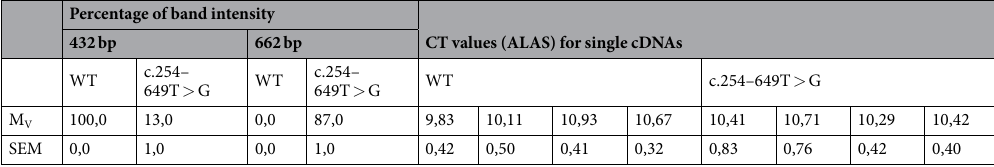
Table 1. Mean and SEM values of the data displayed in Fig.